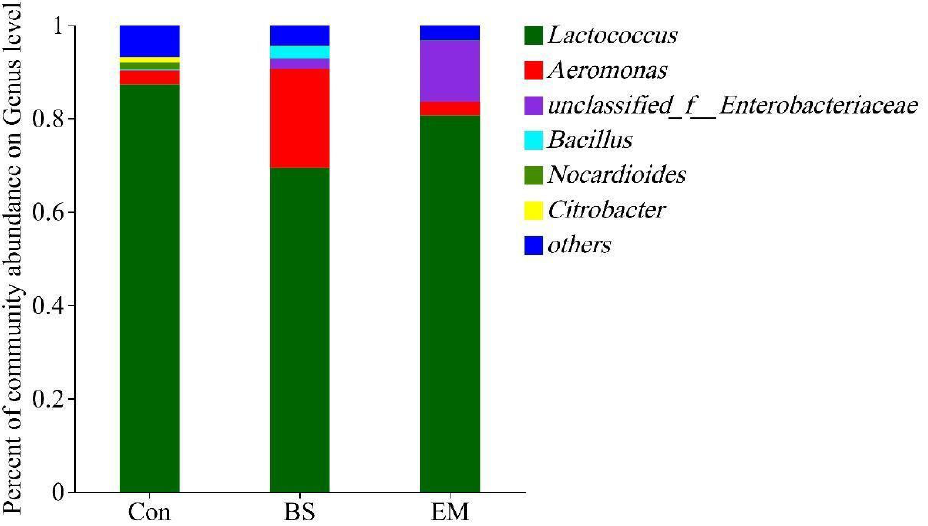
Figure 4. Analysis of dominant flora at genus level in the intestine of M. rosenbergii .